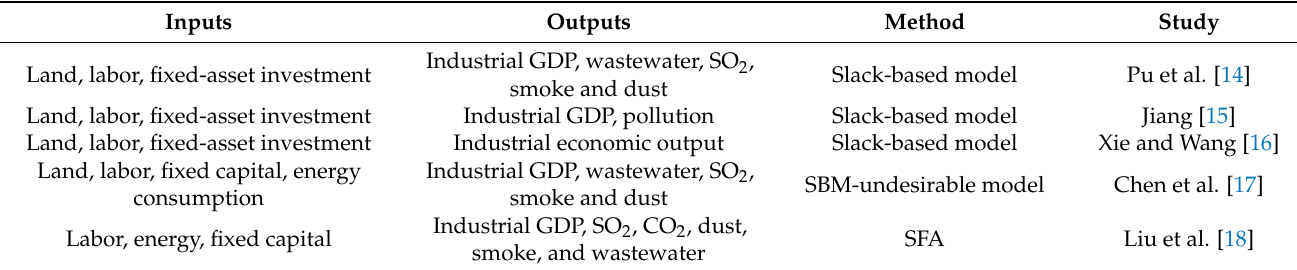
Table 1. Summary of inputs/outputs and methodology of total factor energy